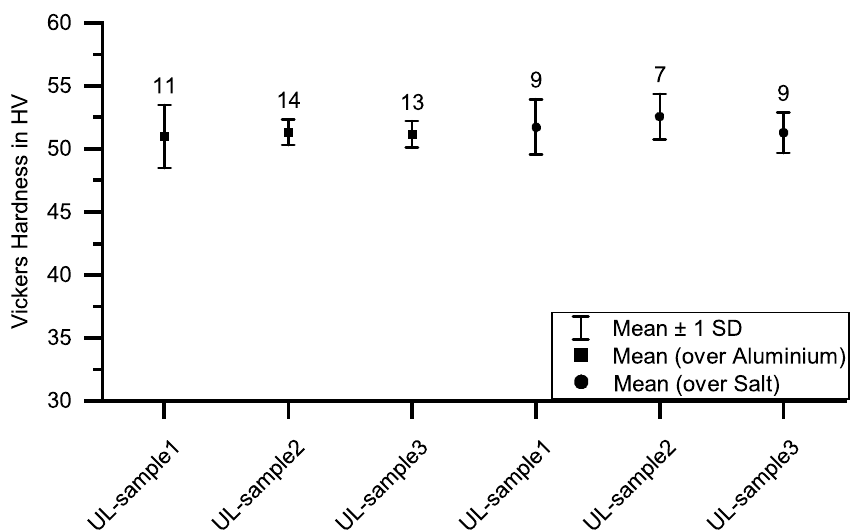
Figure 14. Vickers micro-hardness values in the aluminum part (UL-sample). The squares show the micro-hardness values in the area above the aluminum and the circles show the micro-hardness values above the salt support structure. The numbers above the result points show the number of measurements performed. Based on the measurements, no significant influence of the salt support structure on the micro-hardness occurring in the aluminum can be